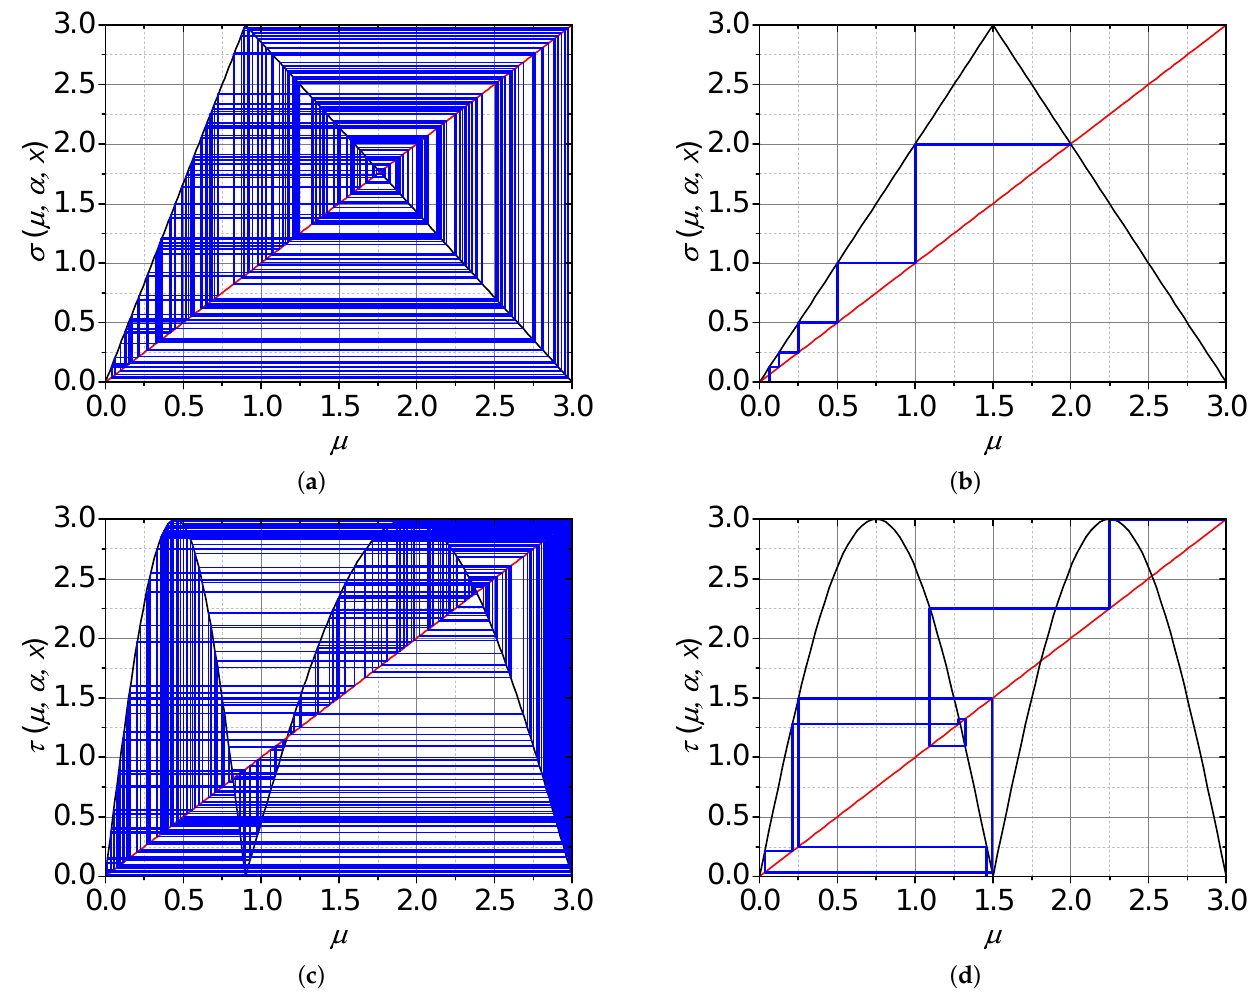
Figure 5. Trajectory diagrams. ( a ) STM when α = 3.0, µ = 0.9, and x 0 = 1.9 (chaotic trajectory), ( b ) STM when α = 3.0, µ = 1.5, and x 0 = 0.0626 (short trajectory reaches the fixed point x ∗ = 2.0), ( c ) FC when α = 3.0, µ = 0.9, and x 0 = 1.9 (chaotic trajectory), and ( d ) FC when α = 3.0, µ = 1.5, and x 0 = 1.460321868288294 (short trajectory reaches the fixed point x ∗ =